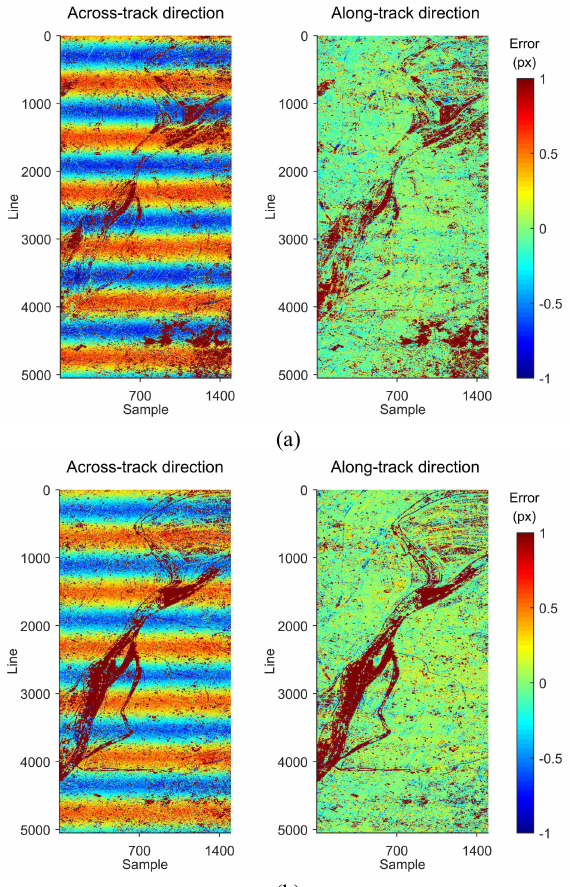
Figure 8 . Parallax maps between (a) B1-B2 and (b) B2-B3 obtained using phase correlation matching